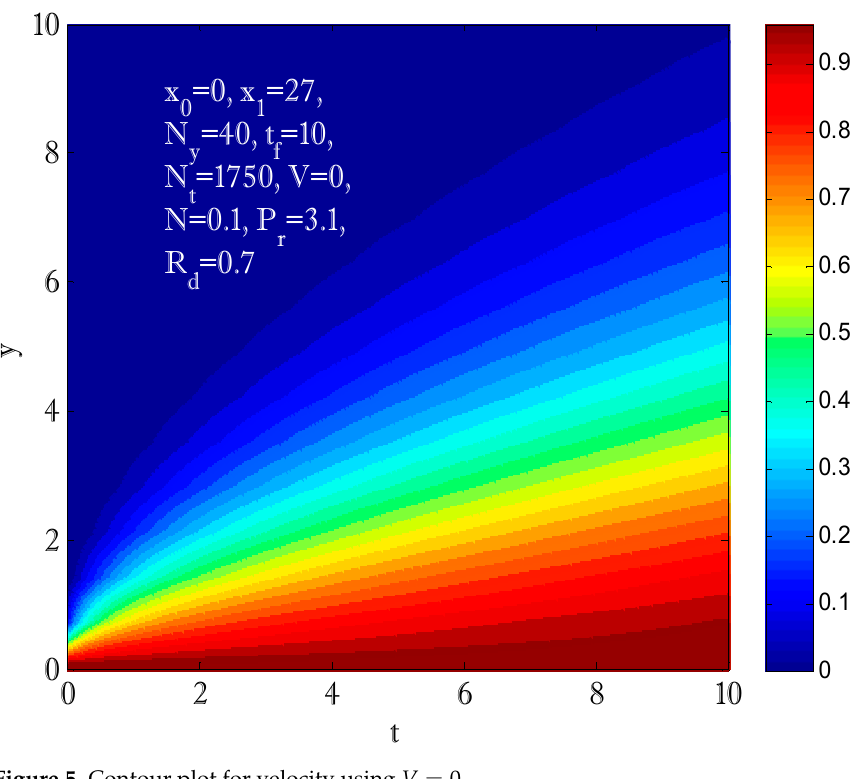
Figure 4. Comparison of the proposed scheme with the Dufort–Frankel method in finding the local Nusselt number through time.